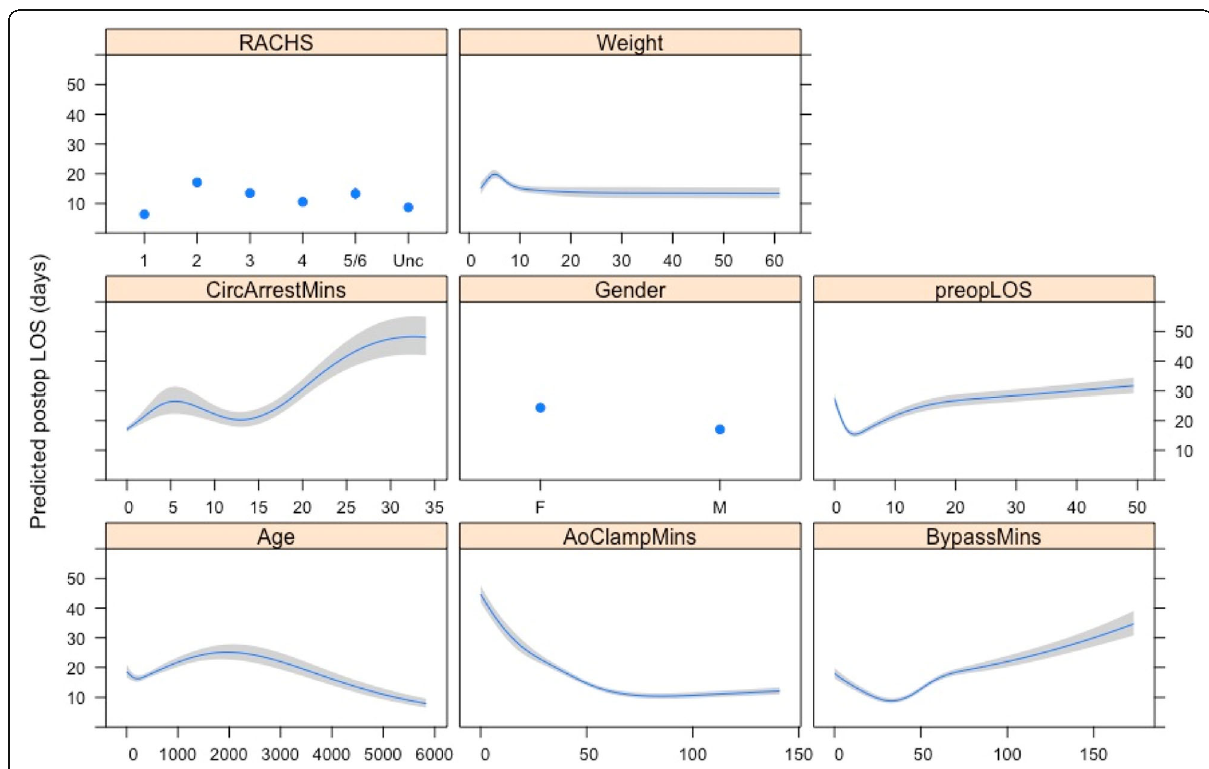
Fig. 1 Graphical description of the relationship between postoperative length of stay in days ( y -axis) and age at operation in days, aortic clamp